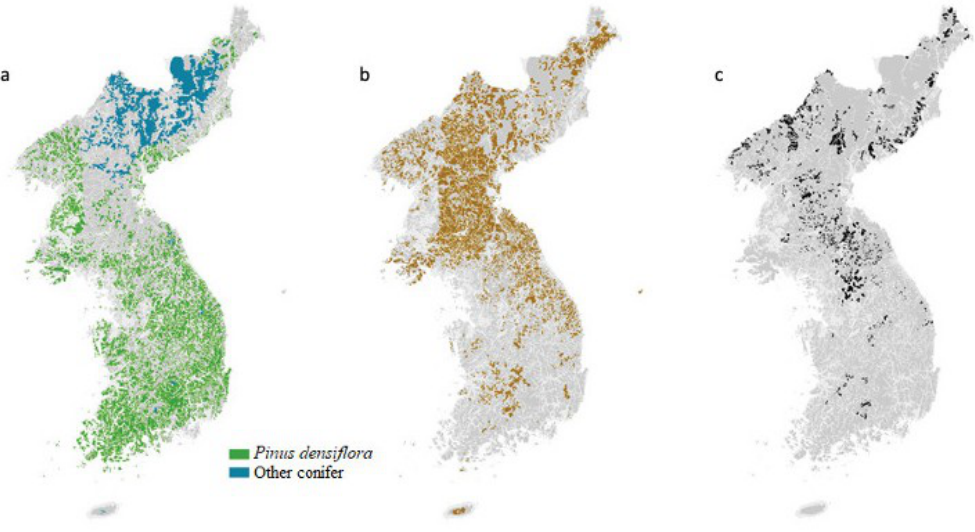
Figure 5. Distribution of forests (total 15.7 million ha) by the dominant species observed by Saito in 1910: ( a ) coniferous forests (41% of total forest land, 30% of which is forest dominated by Korean red pine ( Pinus densiflora) , shown in green), ( b ) deciduous forests (30%), and ( c ) slash and burn Figure 3. (source: Bae and Kim, 2019).